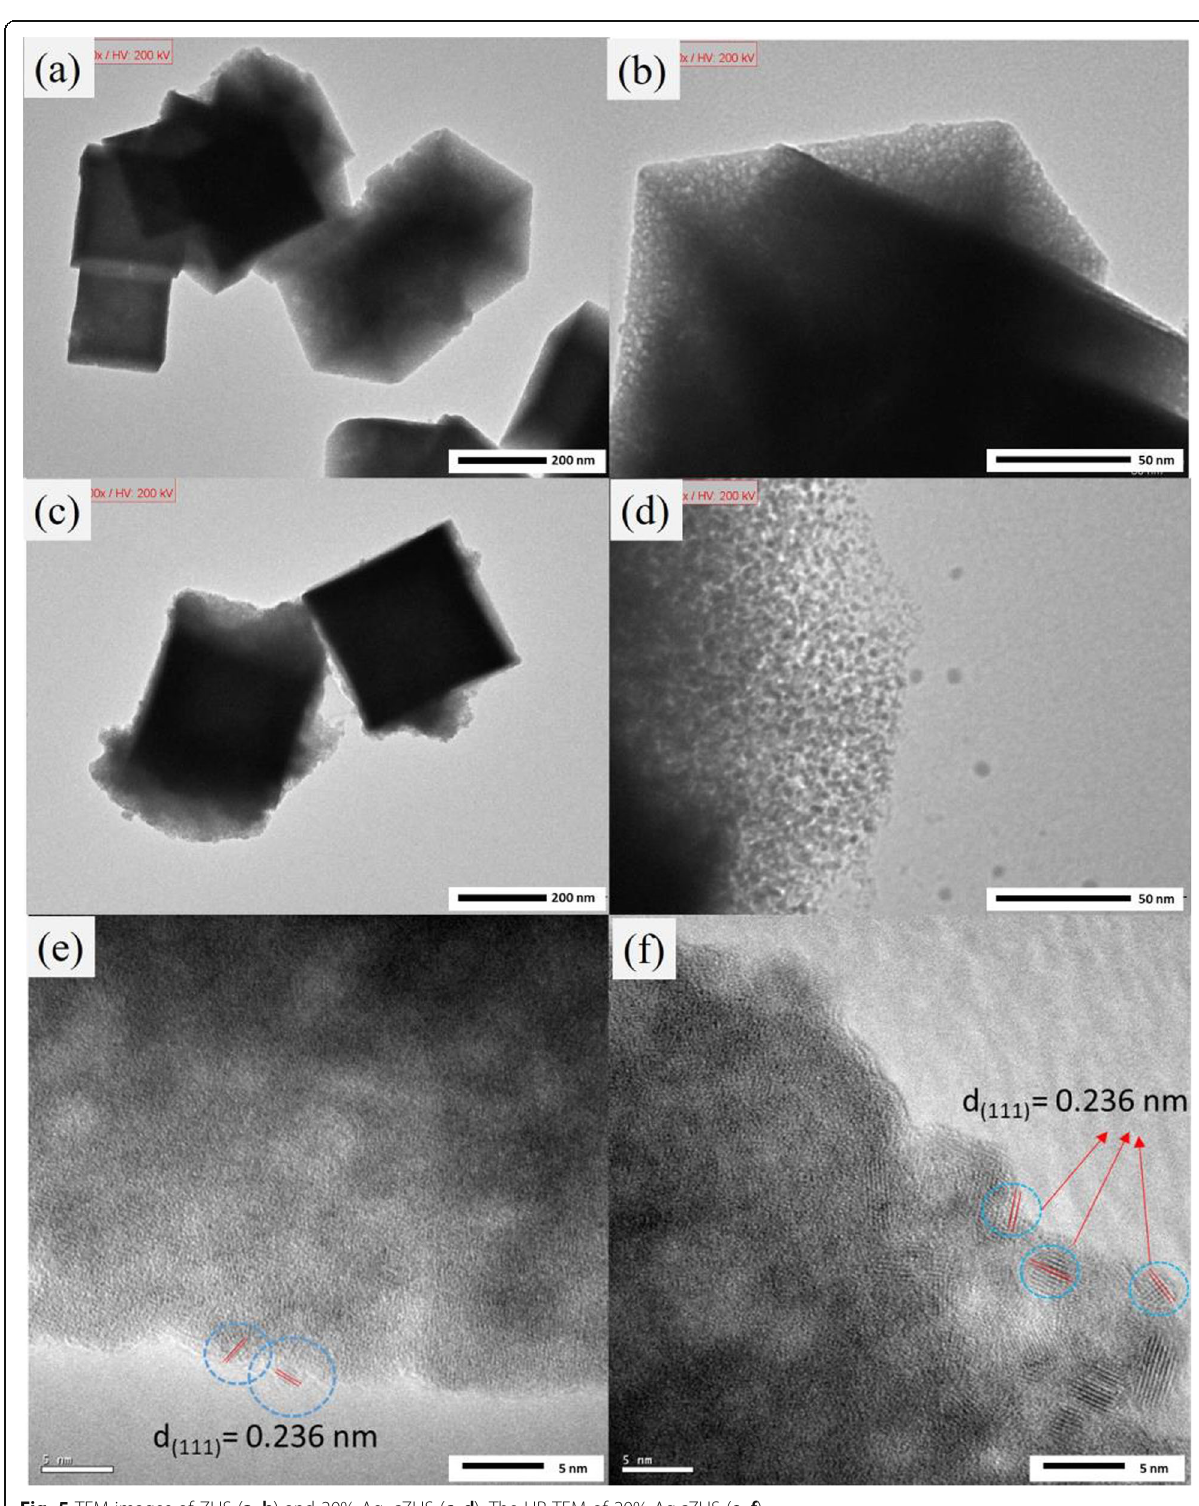
Fig. 5 TEM images of ZHS ( a , b ) and 20% Ag: cZHS ( c , d ). The HR-TEM of 20% Ag;cZHS ( e , f